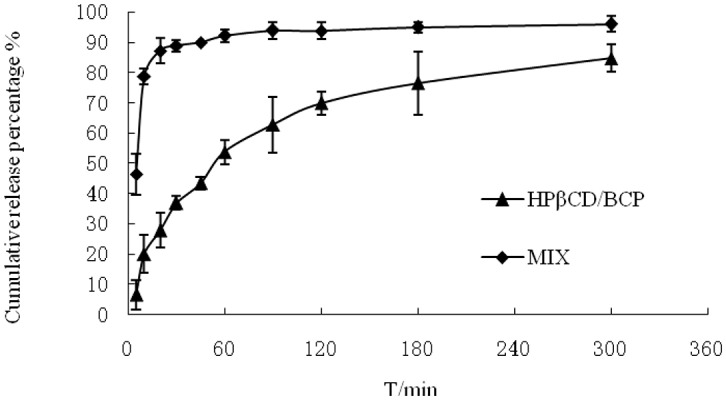
Mean dissolution profiles of HPβCD/BCP and their physical mixture in the mediums phosphate buffer (pH 6.8) (n = 3).